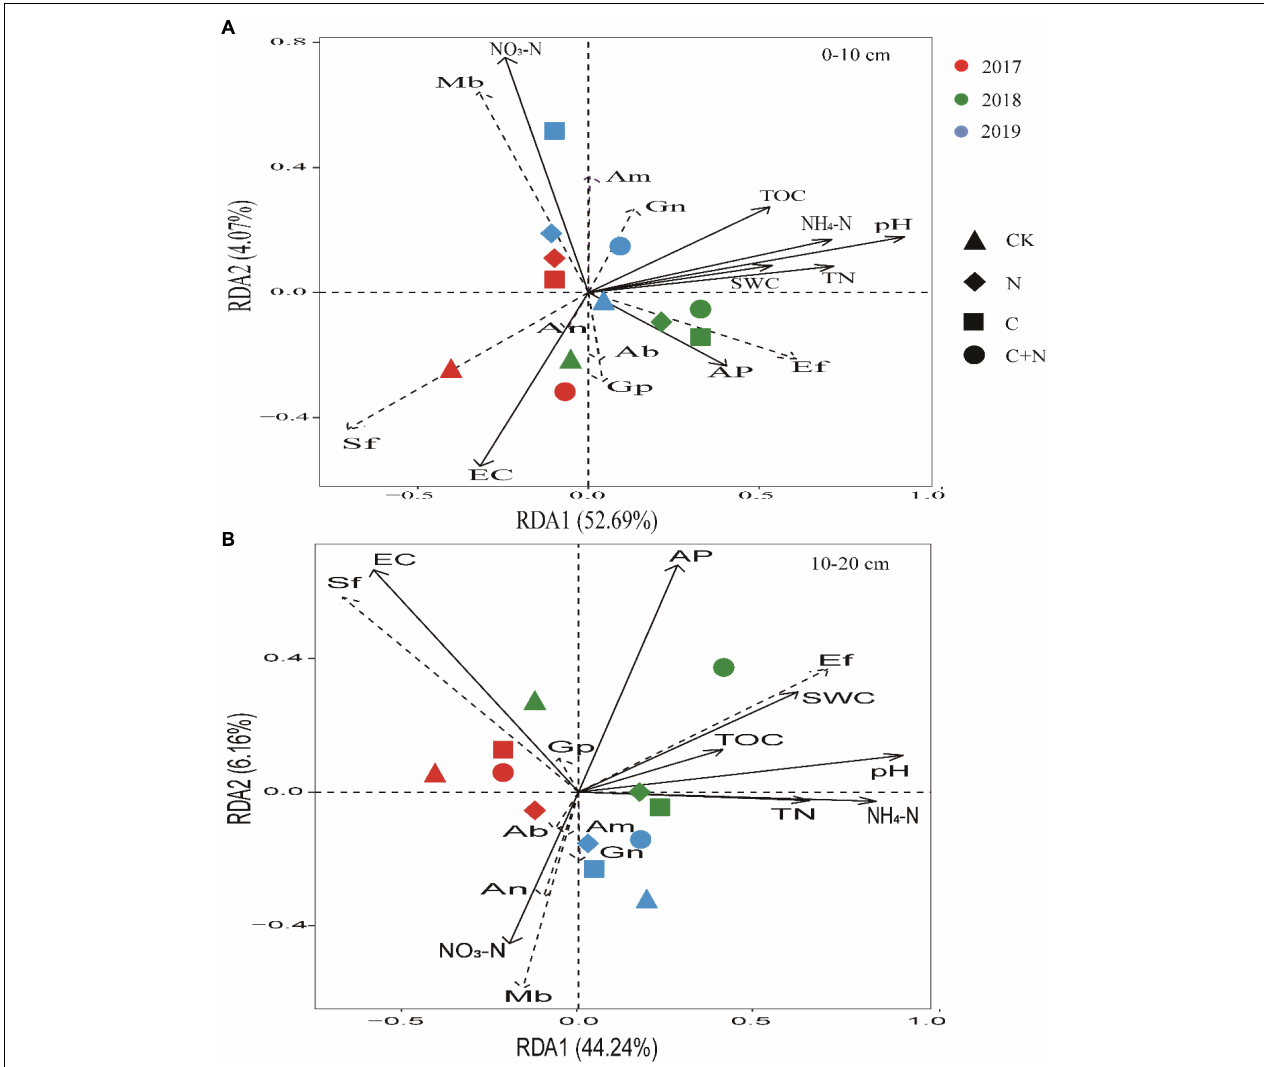
FIGURE 7 | Redundancy analysis (RDA) ordination biplot of soil physicochemical properties and microbes in 0–10 cm soil layer (A) and 10–20 cm soil layer (B) . Soil physicochemical properties were represented by black lines, and microorganism indicators were represented by dashed lines. TOC, total organic carbon; TN, total nitrogen; AP, available phosphorus; NO 3 − -N, soil nitrate–nitrogen; NH 4 + -N, soil ammonia–nitrogen; EC, electrical conductivity; SWC, soil water content. Gn, Gram-negative bacteria; Ab, Actinobacteria; Gp, Gram-positive bacteria; Sf, saprotrophic fungi; Ef, ectomycorrhizal fungi; Mb, methanotrophic bacteria; An, anaerobic bacteria; Am, arbuscular mycorrhizal